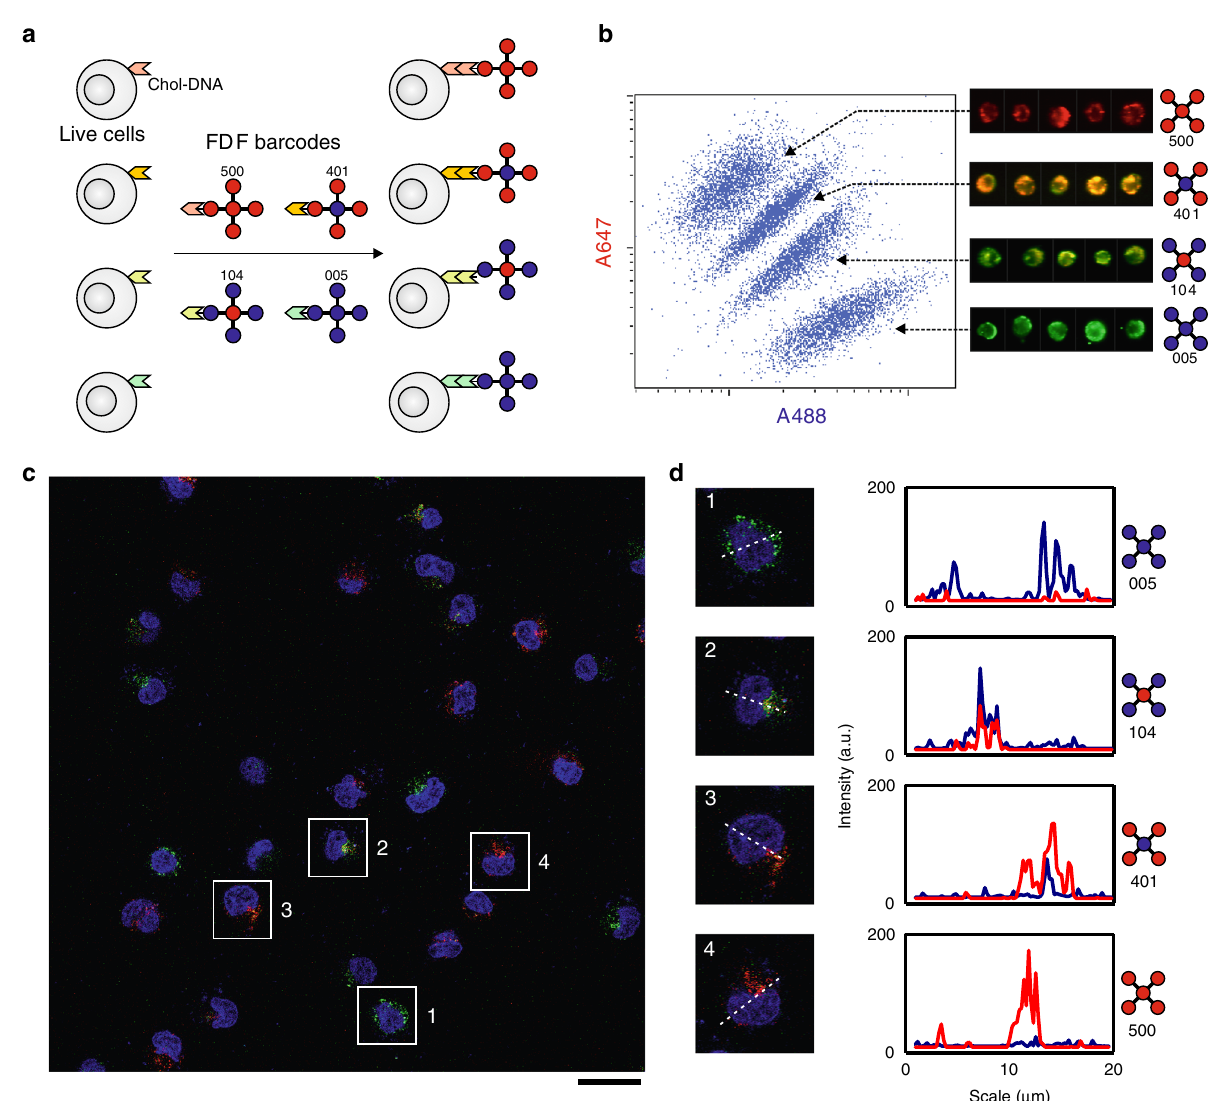
Fig. 6 FDF barcodes for cell imaging and discrimination. a Schematic illustration of FDF barcodes for discrimination of cell populations. b Cytometric scatter plot and representative snapshots of FDF-tagged cells during cell sorting. c Wide-view fl uorescence image of FDF-tagged cells and d representative fl uorescence intensity pro fi les (along the dashed lines in the cell images). Scale bar, 25 μ